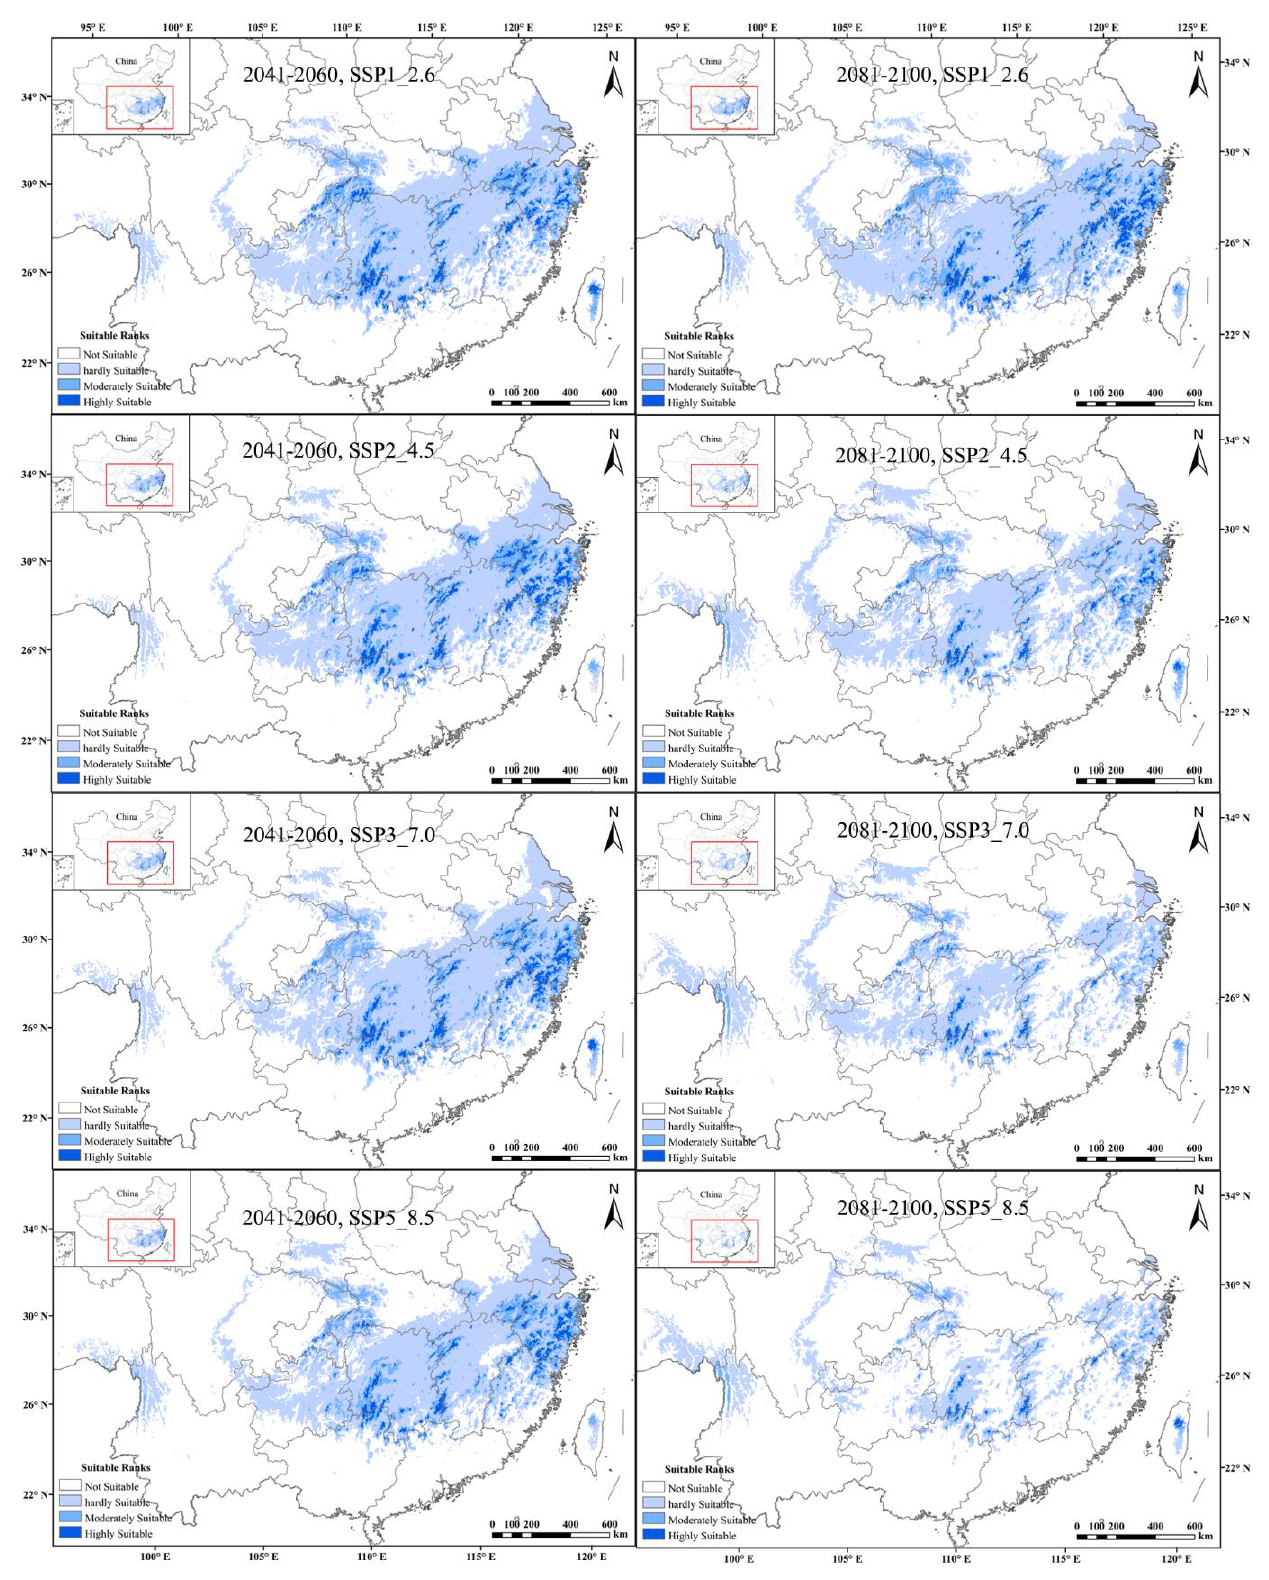
Figure 5. Comprehensive habitat suitability of tetraploid A. chinensis under different future scenarios in China.